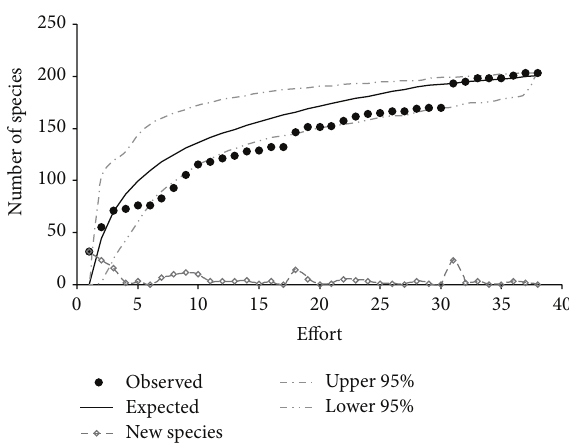
Figure 3: Species accumulation curve, number of new species, and expected number of species according to the von Holdridge richness